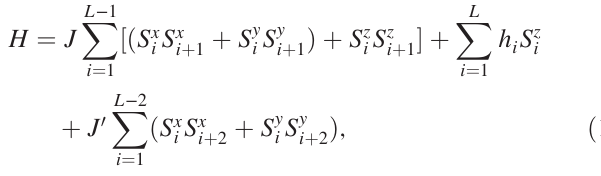
spacing between eigenenergy levels. This ratio is a sensitive test of the level repulsion in a system: It approaches the Gaussian orthogonal ensemble (GOE) value r ≅ 0 . 53 in the thermal phase and the Poisson value r ≅ 0 . 39 in the localized phase. Figure 2(b) shows that the system looks nicely thermal at small W and localized at large W , with the location of the crossing drifting towards larger W with increasing L , as is typical.